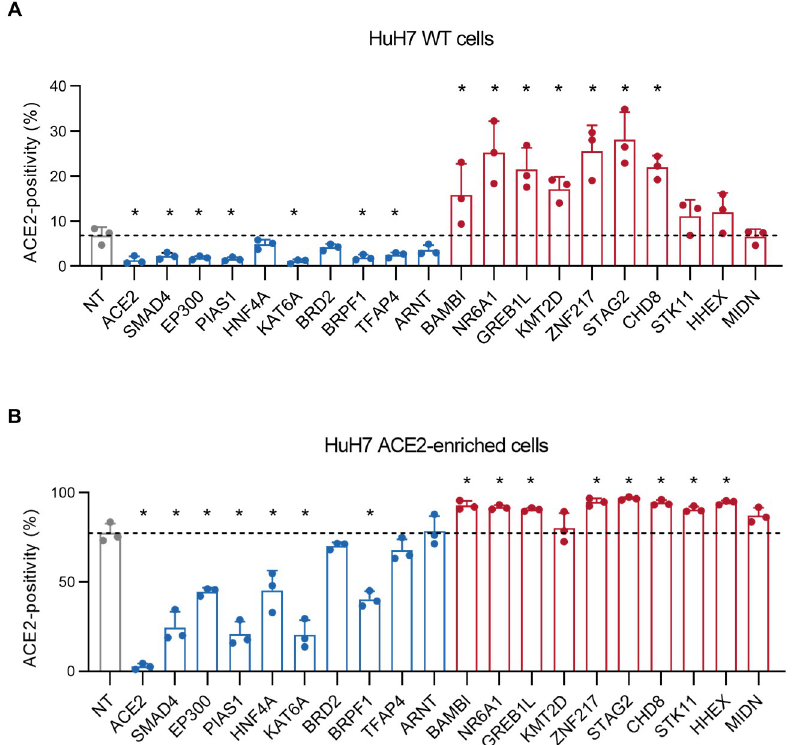
Fig 2. Arrayed validation of ACE2 modifiers. (A-B) Percentage of surface ACE2-positive cells after CRISPR- mediated single gene disruption of the indicated target gene or a nontargeting control on either a HuH7 parental wild- type (A) or serially ACE2-enriched background (B). Candidate genes associated with positive or negative regulation of ACE2 in the CRISPR screen are highlighted in blue and red, respectively. ACE2-positive gates were defined on control unstained HuH7 wild-type cells and the proportion of ACE2-positive cells for each population is displayed for each of 3 independent biologic replicates. Error bars depict standard deviation. Asterisks indicated p-value < 0.05 relative to nontargeting controls by Student’s t-test. Source data and statistical analysis are provided in S9